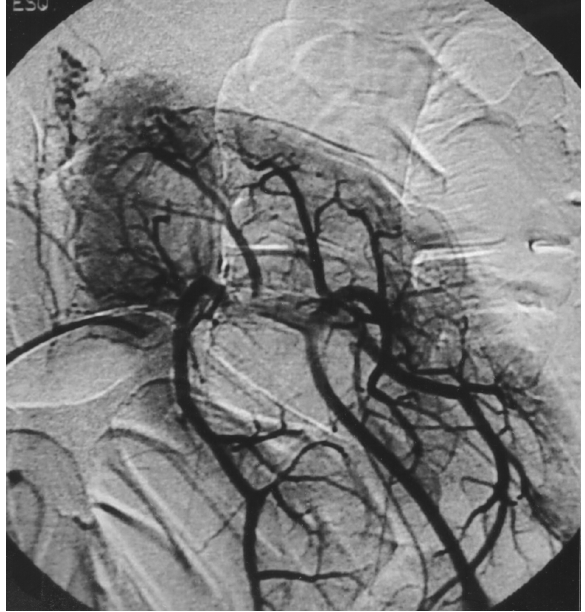
Figure 2 – Arteriography showing pathological circulation in left adrenal